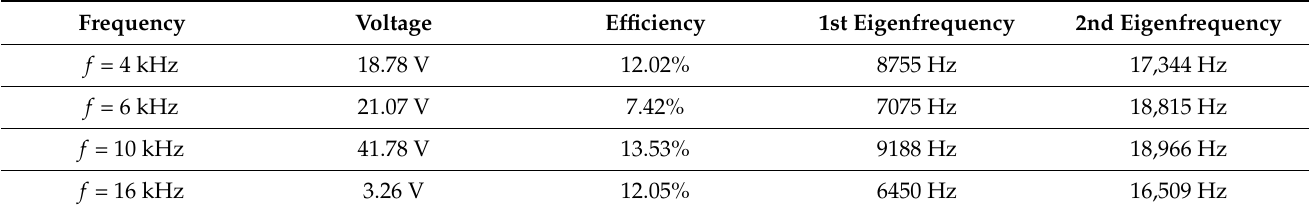
Table 3. The optimized results of the open-circuit voltage enhanced designs.